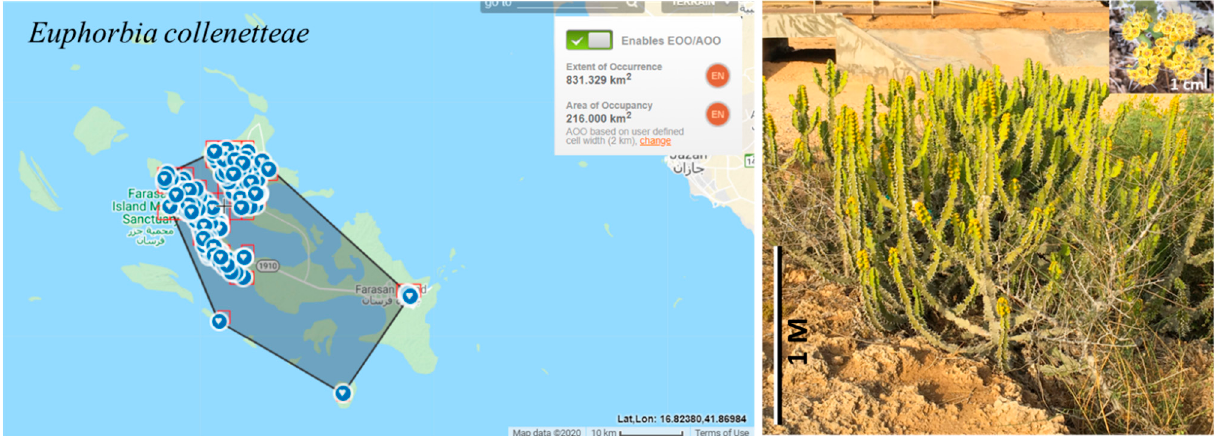
Figure 11. Geographical distribution of Euphorbia collenetteae in the Farasan Archipelago. Photo by S. Alharbi from Farasan Alkabir Island.